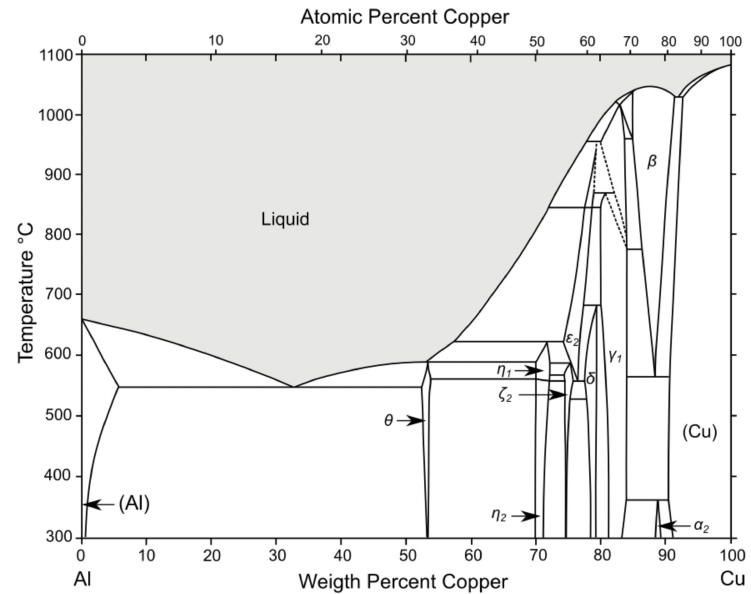
Figure 19. Binary Al–Cu phase diagram. Redrawn from [88] with permission. Table 6. Characteristics of different Cu x Al y phases forming at room temperature [88,148,151,154–158]. Composition of Cu (in wt.%) varies depending on